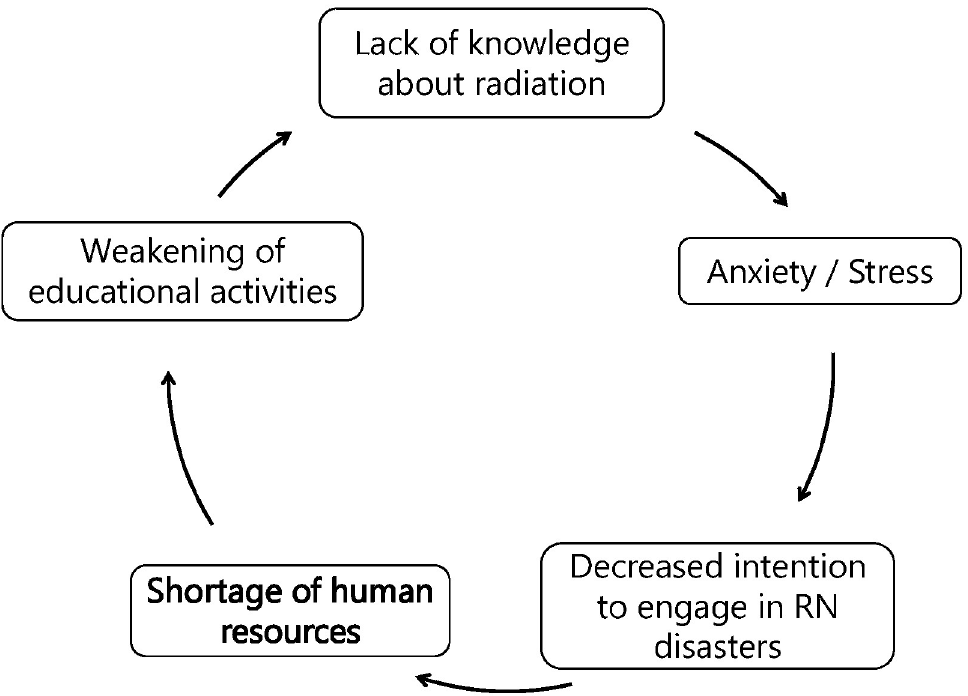
Fig 1. Negative chain of anxiety and stress in radiation emergency medicine